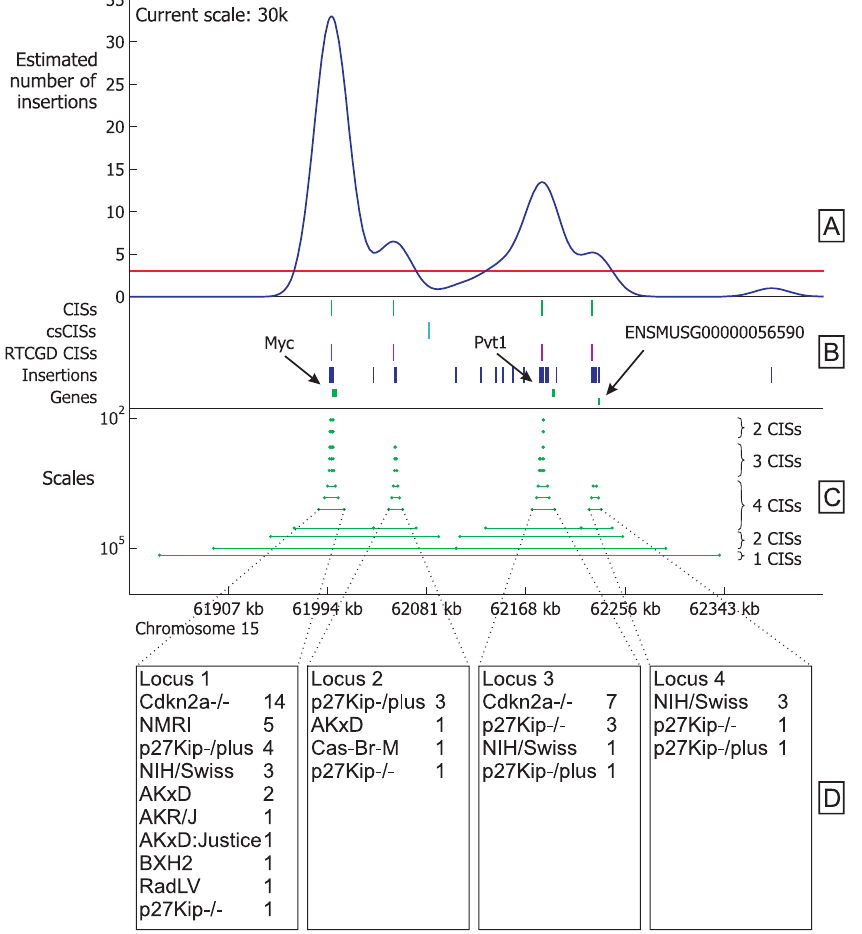
Figure 3. The Myc Locus on Chromosome 15 (A) The blue line represents the estimated number of insertions as a function of position for a certain region. The red line depicts the threshold associated with an a -level of 0.05. (B) CISs are depicted by means of vertical lines. From top to bottom these represent: the CISs for the current scale (30k), the csCISs, the CISs from the RTCGD, the insertions, and the genes (top and bottom strand separated). (C) Scale space diagram. The vertical axes of the scale space has a logarithmic scale and indicates the scale for which the CIS was detected (only a subset of scales was actually evaluated: [50 100 250 500 1 k 2.5 k 5 k 10 k 30 k 50 k 100 k 150 k] bp). (D) Evaluation of the insertion distribution over four small scale CISs, identified by scale space analysis. Per screen we list the number of insertions that fall within the small scale CIS. The screens are labeled consistent with RTCGD